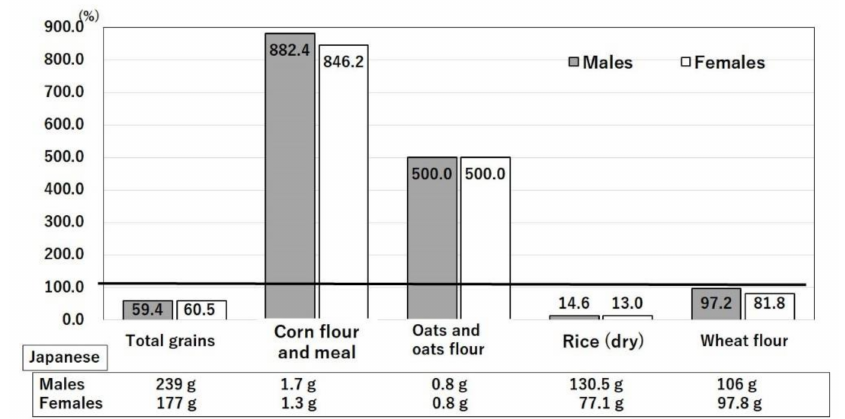
Figure 10. Ratios of grain intakes in the U.S. compared with Japan. Values are g/day/person in the age range of 40–49 years. The intake of each item in Japan was taken as 100% [14]. The actual values of Japanese intakes are shown below each bar. United States Department of Agriculture, NHANES 2017–2018, individuals 2 years and over (excluding breast-fed children). www.ars.usda. gov/nea/bhnrc/fsrg (accessed 10 December 2021) and Ministry of Health, Labor and Welfare of Japan. The National Health and Nutrition Survey Japan, 2019. https://www.mhlw.go.jp/bunya/ kenkou/kenkou_eiyou_chousa.html (accessed 10 December